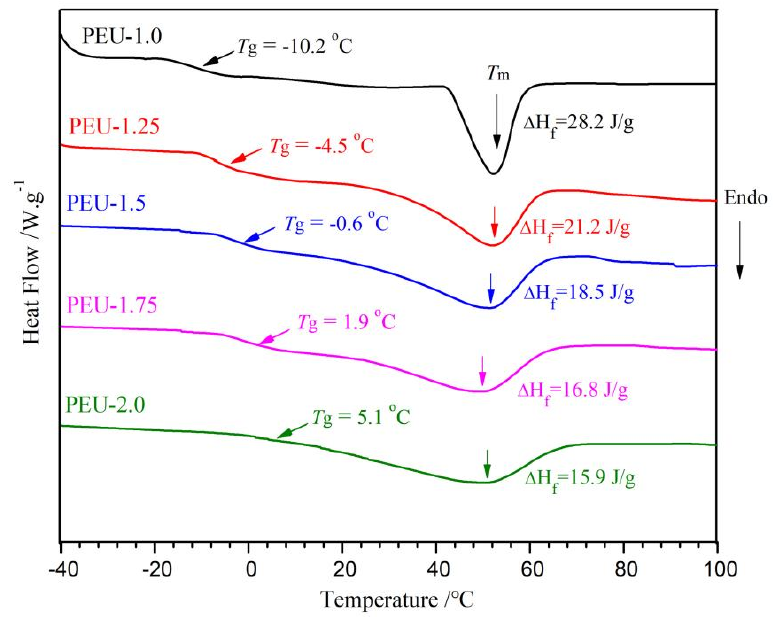
Figure 5. DSC thermograms regarding PEU films.